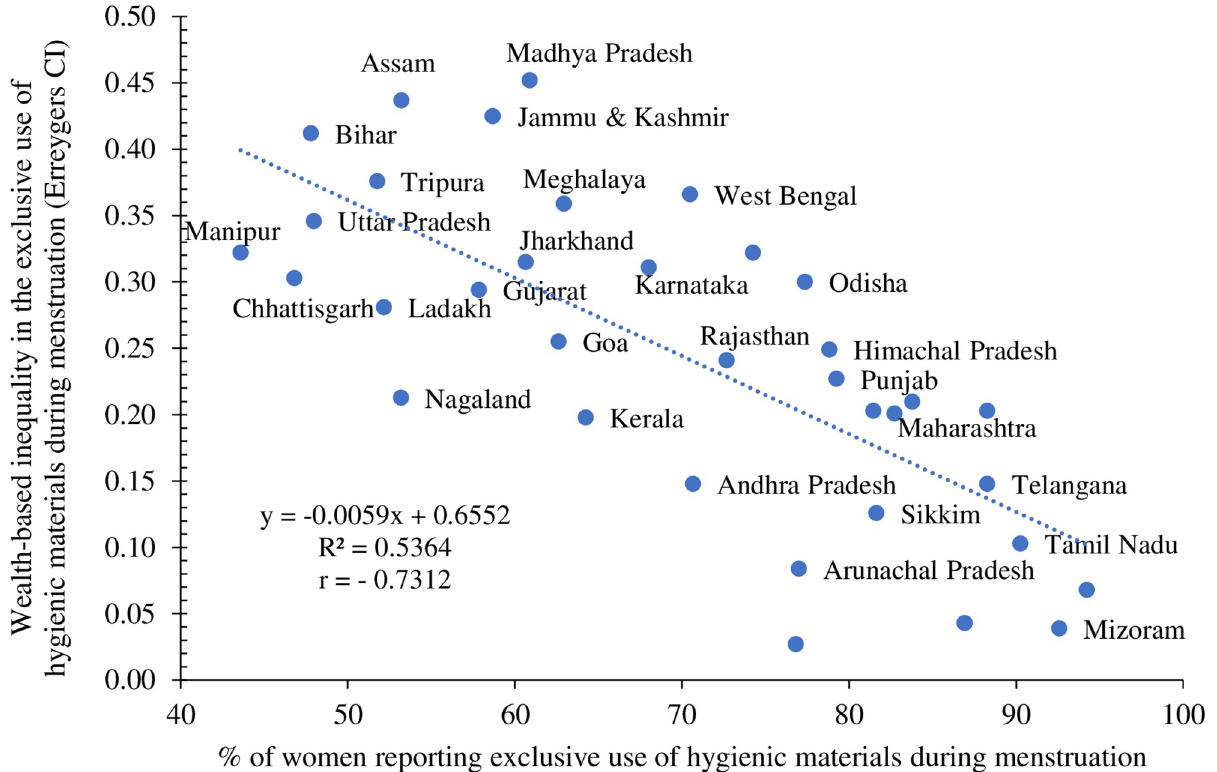
Fig 6. Association between level of exclusive use of hygienic materials and wealth-based inequality in the same among urban women aged 15–24 years across the states & UTs � of India, NFHS-5, 2019–21. Note: � Excluding Lakshadweep which was an outlier.